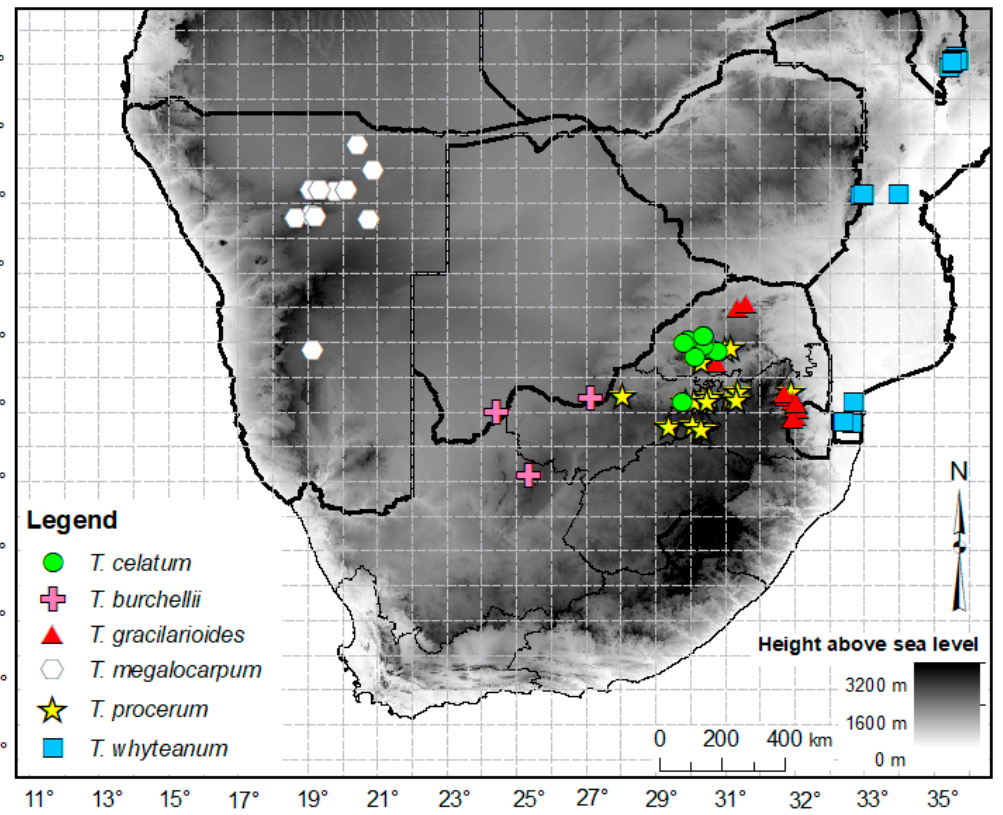
Figure 4. Geographical distributions of Thesium celatum (green circles) and five morphologically similar species, T. burchellii (pink crosses), T. gracilarioides (red triangles), T. megalocarpum (white pentagons), T. procerum (yellow stars), and T. whyteanum (blue